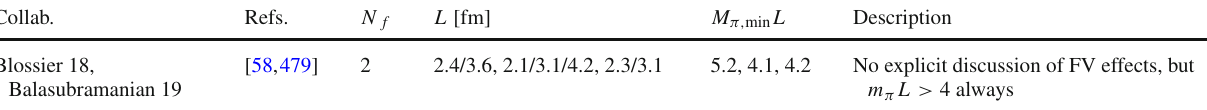
Table 128 Finite-volume effects in N f = 2 determinations of the D - and D s -meson decay constants. Each L -entry corresponds to a different lattice spacing, with multiple spatial volumes at some lattice spacings. For actions with multiple species of pions, the lightest masses are quoted Collab.